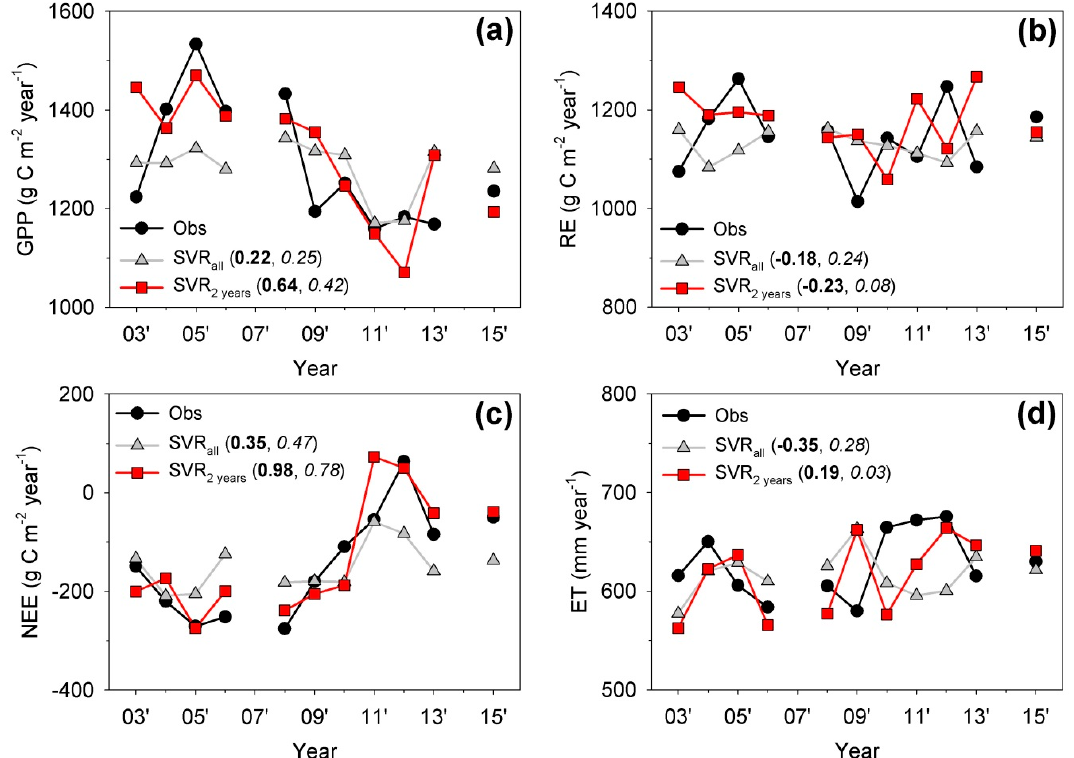
Figure 8. Interannual variations of GPP ( a ), RE ( b ), NEE ( c ), and ET ( d ) for the study site over the entire study period from the observations (Obs), SVR ‐ based model trained using all available data except for the target year (SVR all ), and SVR ‐ based model using two years of data around the target year (SVR 2 years ). The numbers in parentheses represent the slope (bold) and r 2 (italic) from the linear regression of the observations.